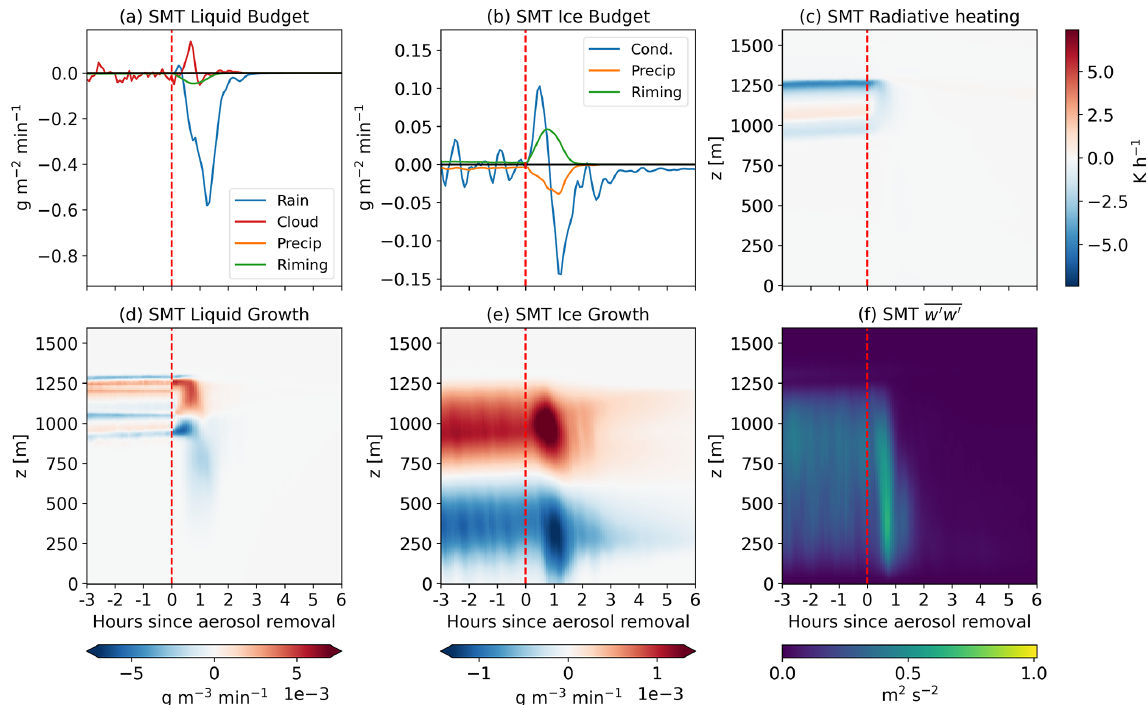
Figure 9. Same as Figs. 7 and 8 for